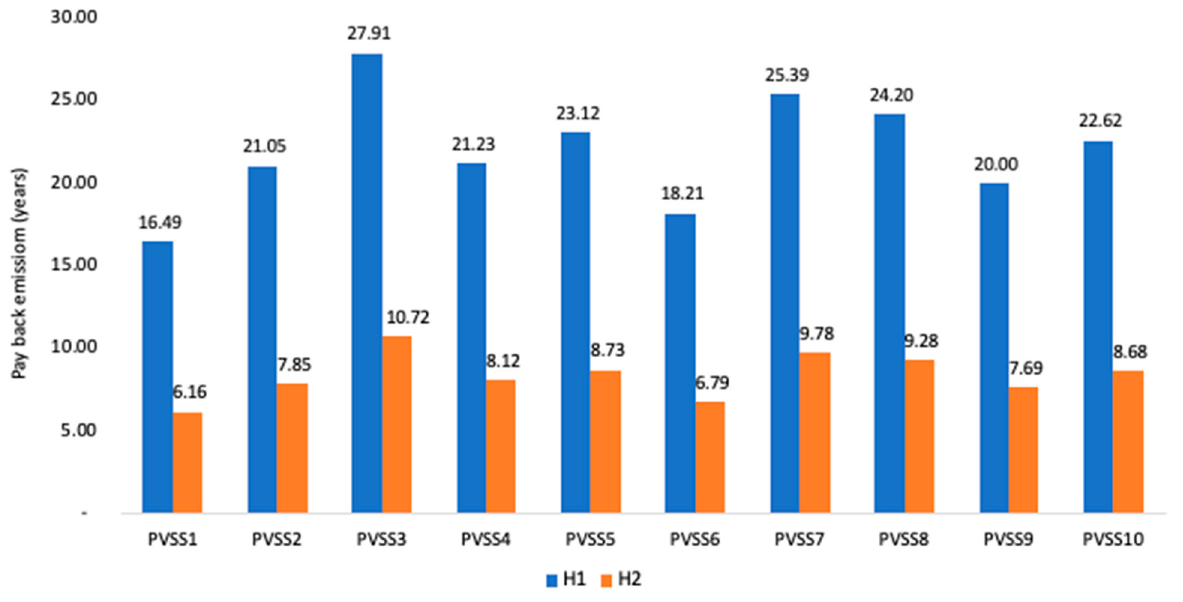
Figure 10 . Comparison between payback emission time for different estimates of the national emission factors. With regard to CO 2-eq emissions, it can be seen in the results of Table 4 that the emis- sion return time decreases considerably when compared to Table 3. This occurs because